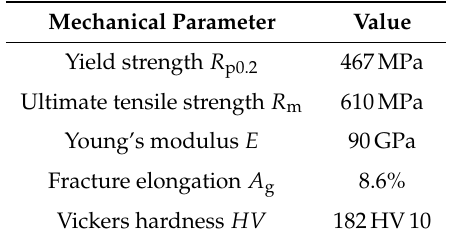
Table 1. Mechanical properties of the investigated composite.